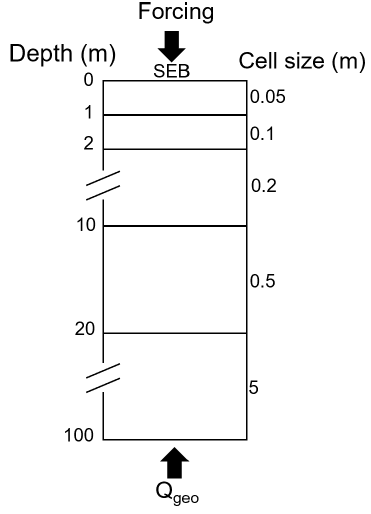
Figure 2. Schematic of the model grid, indicating cell sizes at dif- ferent depths and upper and lower boundary conditions. As an up- per boundary condition, the surface energy balance (SEB) forced by near-surface meteorological data is used. The lower boundary condition is provided by a constant geothermal heat flux, Q geo